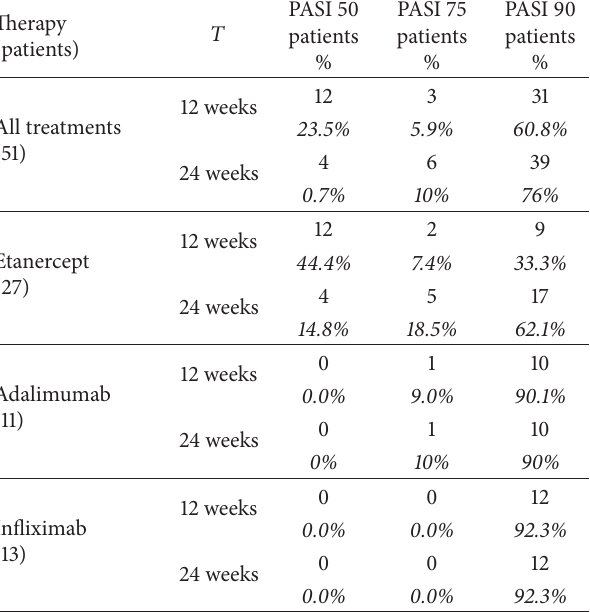
Table 1: Clinical characteristics of patients and